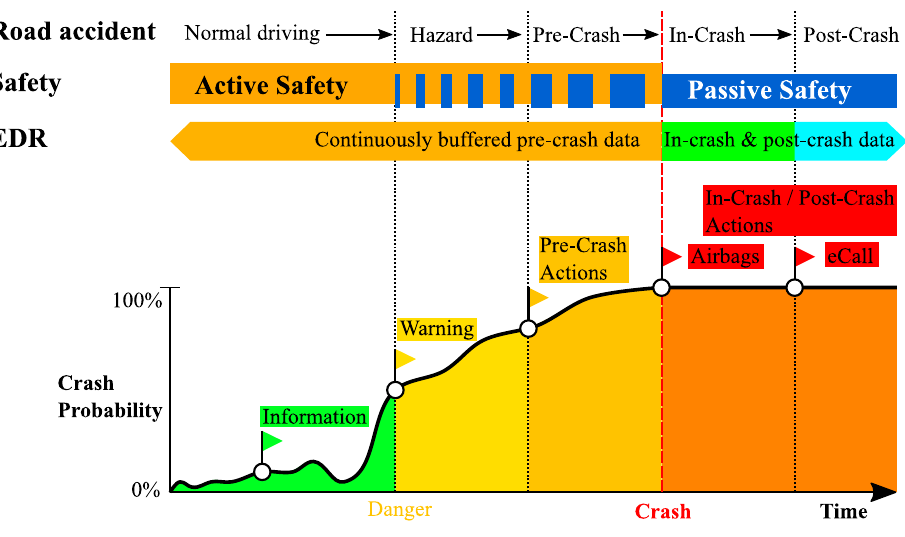
Figure 1. Phases of an accident.